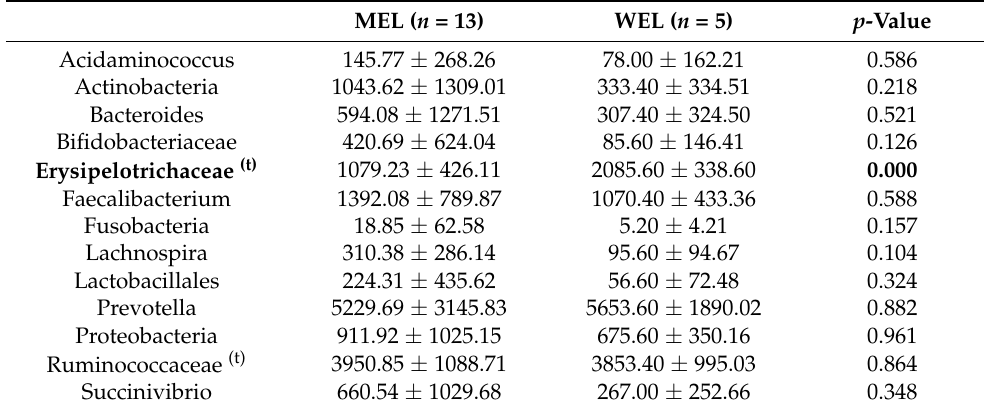
Table A7. Number of readings of the main bacterial taxa in the gut microbiota by dietary patterns in